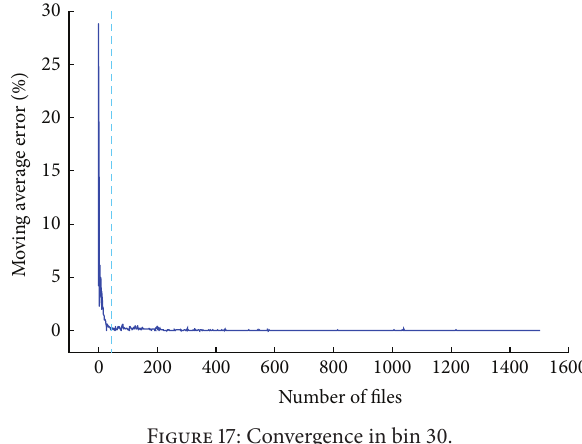
Figure 17: Convergence in bin